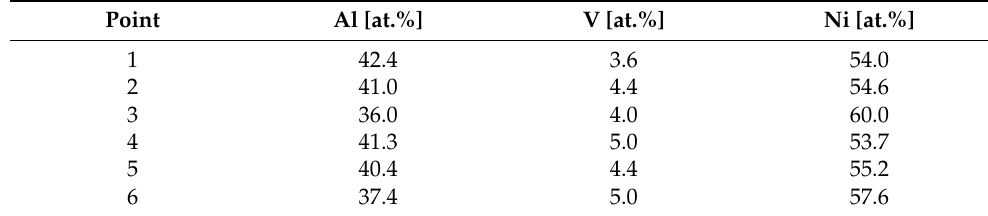
Figure 12. STEM micrograph of the Al/Ni thin film following ignition by mode II ( φ = 0.05 mm W wire), indicating the points where EDS analyses were carried out.